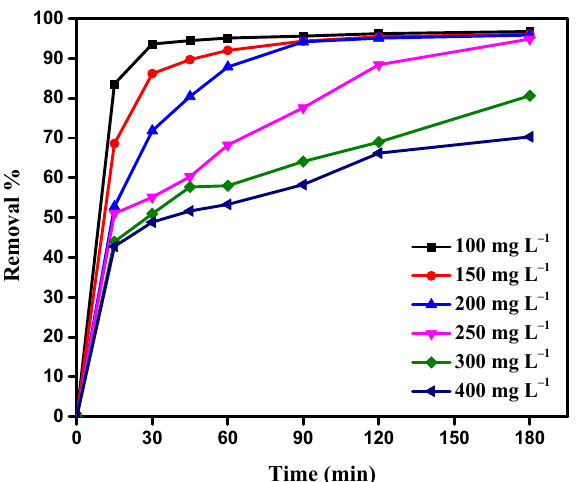
Figure 7. The removal of AY11 dye for 3 h using MBT as an adsorbent ( C 0 of AY11 dye: 100–400 mg L –1 , MBT dose = 0.75 g L −1 , RT = 24 ± 2 °C).